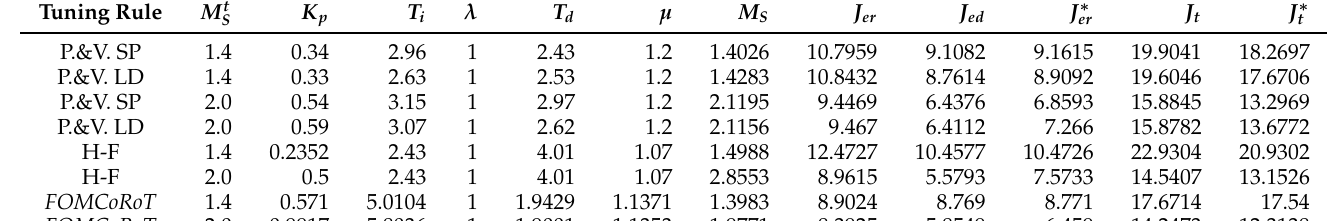
Table 5. Comparison between tuning rules for FOPID in the control of an integer process.